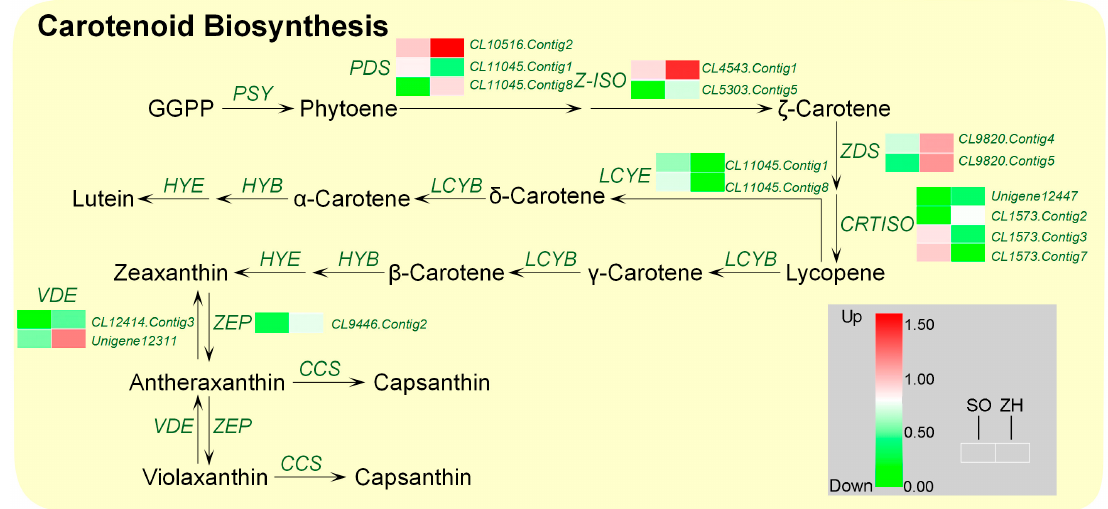
Figure 11. Expression profiles of DEGs involved in carotenoid biosynthesis between ‘SO’ and ‘ZH’.